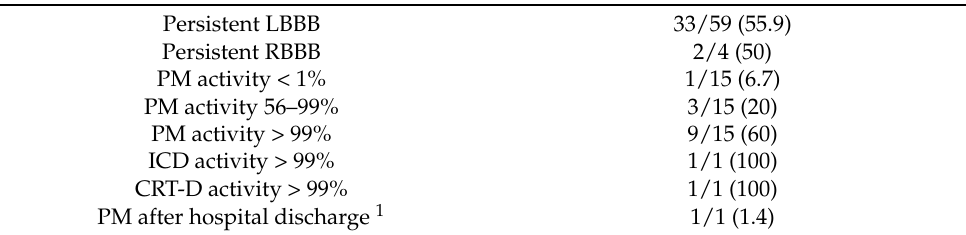
Table 2. Postoperative conduction disorders at medium-term follow-up (526 days, SD = 169.6, SE = 19.3). Persistent LBBB 33/59 (55.9) Persistent RBBB 2/4 (50) PM activity < 1% 1/15 (6.7) PM activity 56–99% 3/15 (20) PM activity > 99% 9/15 (60) ICD activity > 99% 1/1 (100) CRT-D activity > 99% 1/1 (100) PM after hospital discharge 1 1/1 (1.4) Values are given as absolute numbers with % in parentheses. AV block III, atrioventricular block III; CRT-D, cardiac resynchronization therapy–defibrillator; ICD, implantable cardioverter defibrillator; LBBB, left bundle branch block; RBBB, right bundle branch block. 1 Patient with LBBB and AV block II Mobitz type